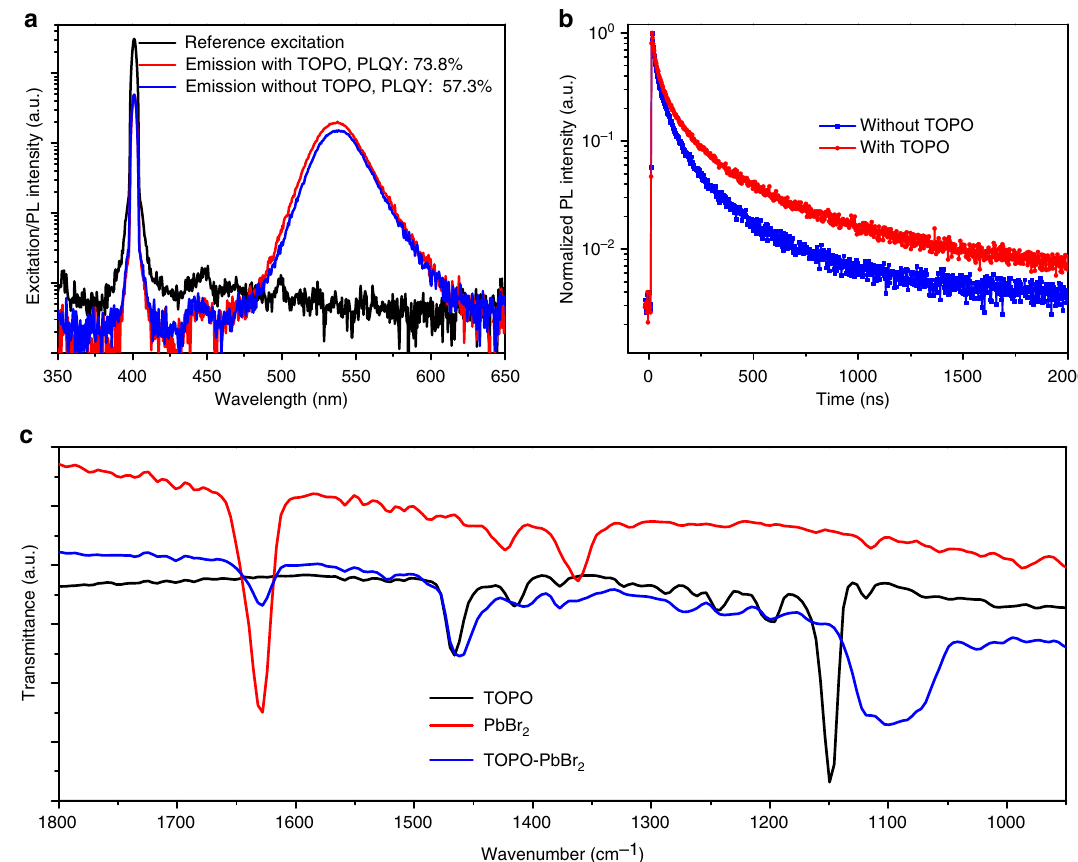
Fig. 2 Passivation effect of TOPO on the perovskite with n = 3 composition. a Photoluminescence quantum yield (PLQY) of the PEA 2 (FAPbBr 3 ) n -1 PbBr 4 ( n = 3 composition) perovskite fi lms with and without TOPO passivation. b Time-resolved photoluminescence (TRPL) of the PEA composition) fi lms with and without TOPO passivation layer. c Fourier transform infrared (FTIR) spectroscopy measurement for TOPO, PbBr 2 and